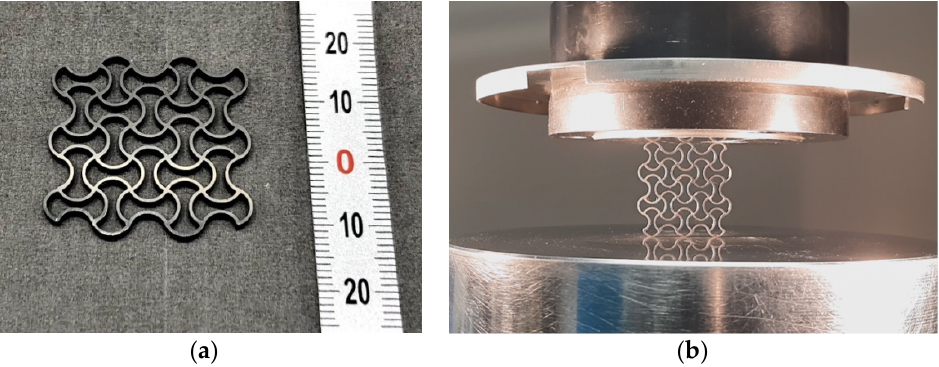
Figure 12. ( a ) Sintered auxetic component, wall thickness 0.5 mm. ( b ) Sample in cyclic compression test (video in Supplementary Materials).